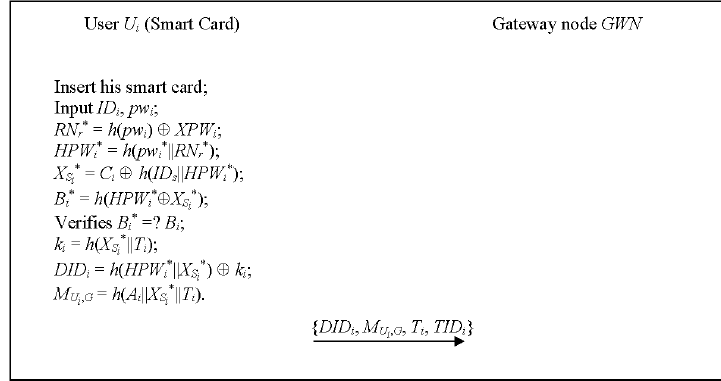
Figure 2. The login phase of the proposed scheme for WSNs.